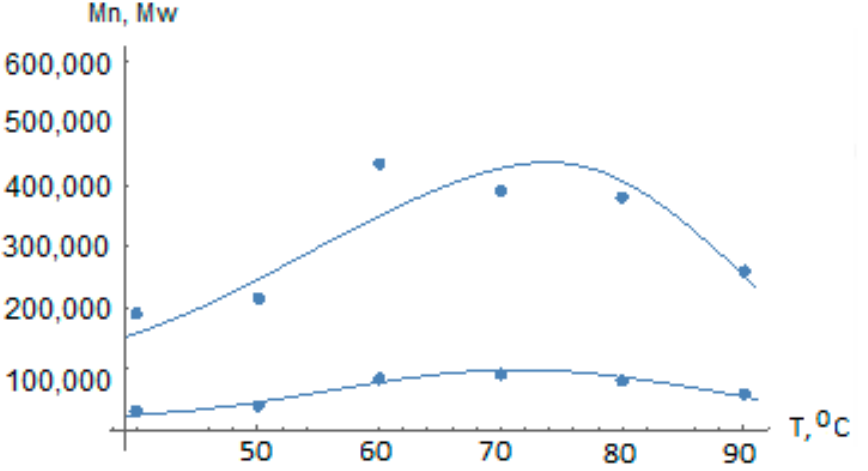
Figure 7. Comparison of the dependences 𝑀 (cid:3041) (120, 𝑇) and 𝑀 (cid:3050) (120, 𝑇) calculated by the polycen- tric model with the activation energies from Table 3, and the experimental data from Table 1 (rela- tive error Δ n 40 = 0.196, Δ n 50 = 0.156, Δ n 60 = 0.067, Δ n 70 = 0.079, Δ n 80 = 0.075, Δ n 90 = 0.071; Δ w 40 = 0.167, Δ w 50 = 0.139, Δ w 60 = 0.195, Δ w 70 = 0.095, Δ w 80 = 0.070, Δ w 90 = 0.027).